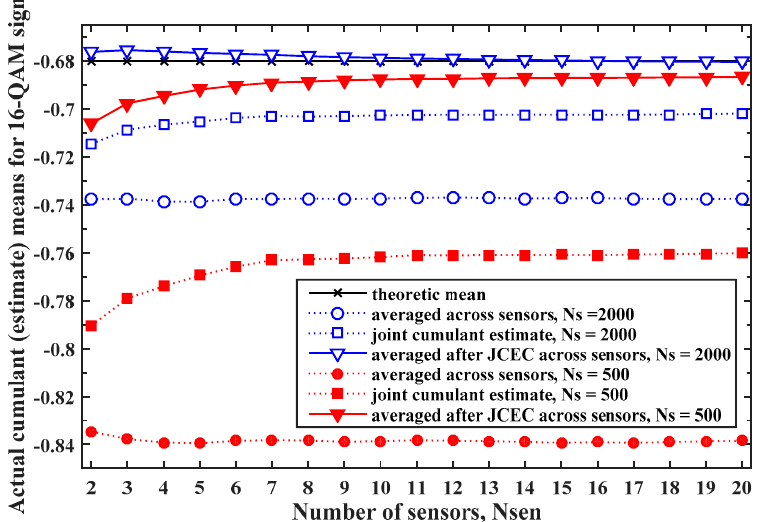
Figure 3. The actual cumulant (estimate) means for the 16QAM signal, with and without the joint cumulant estimate correction (JCEC) used for the MC with the blind channel estimation method (BCEM), averaged over di ff erent number of sensors with SNR = ( 10 ± 2 ) dB and random L ∈ { 2, ··· , 5 } .